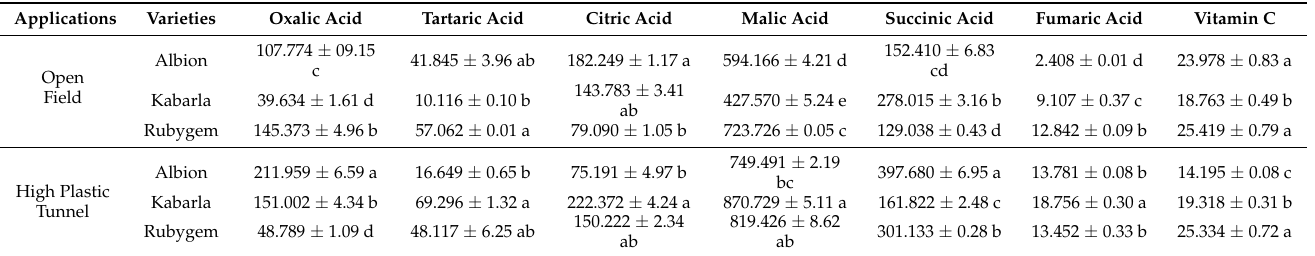
Table 2. The content of organic acids in fruits of strawberry cultivars grown in open field and high plastic tunnel (mg/100